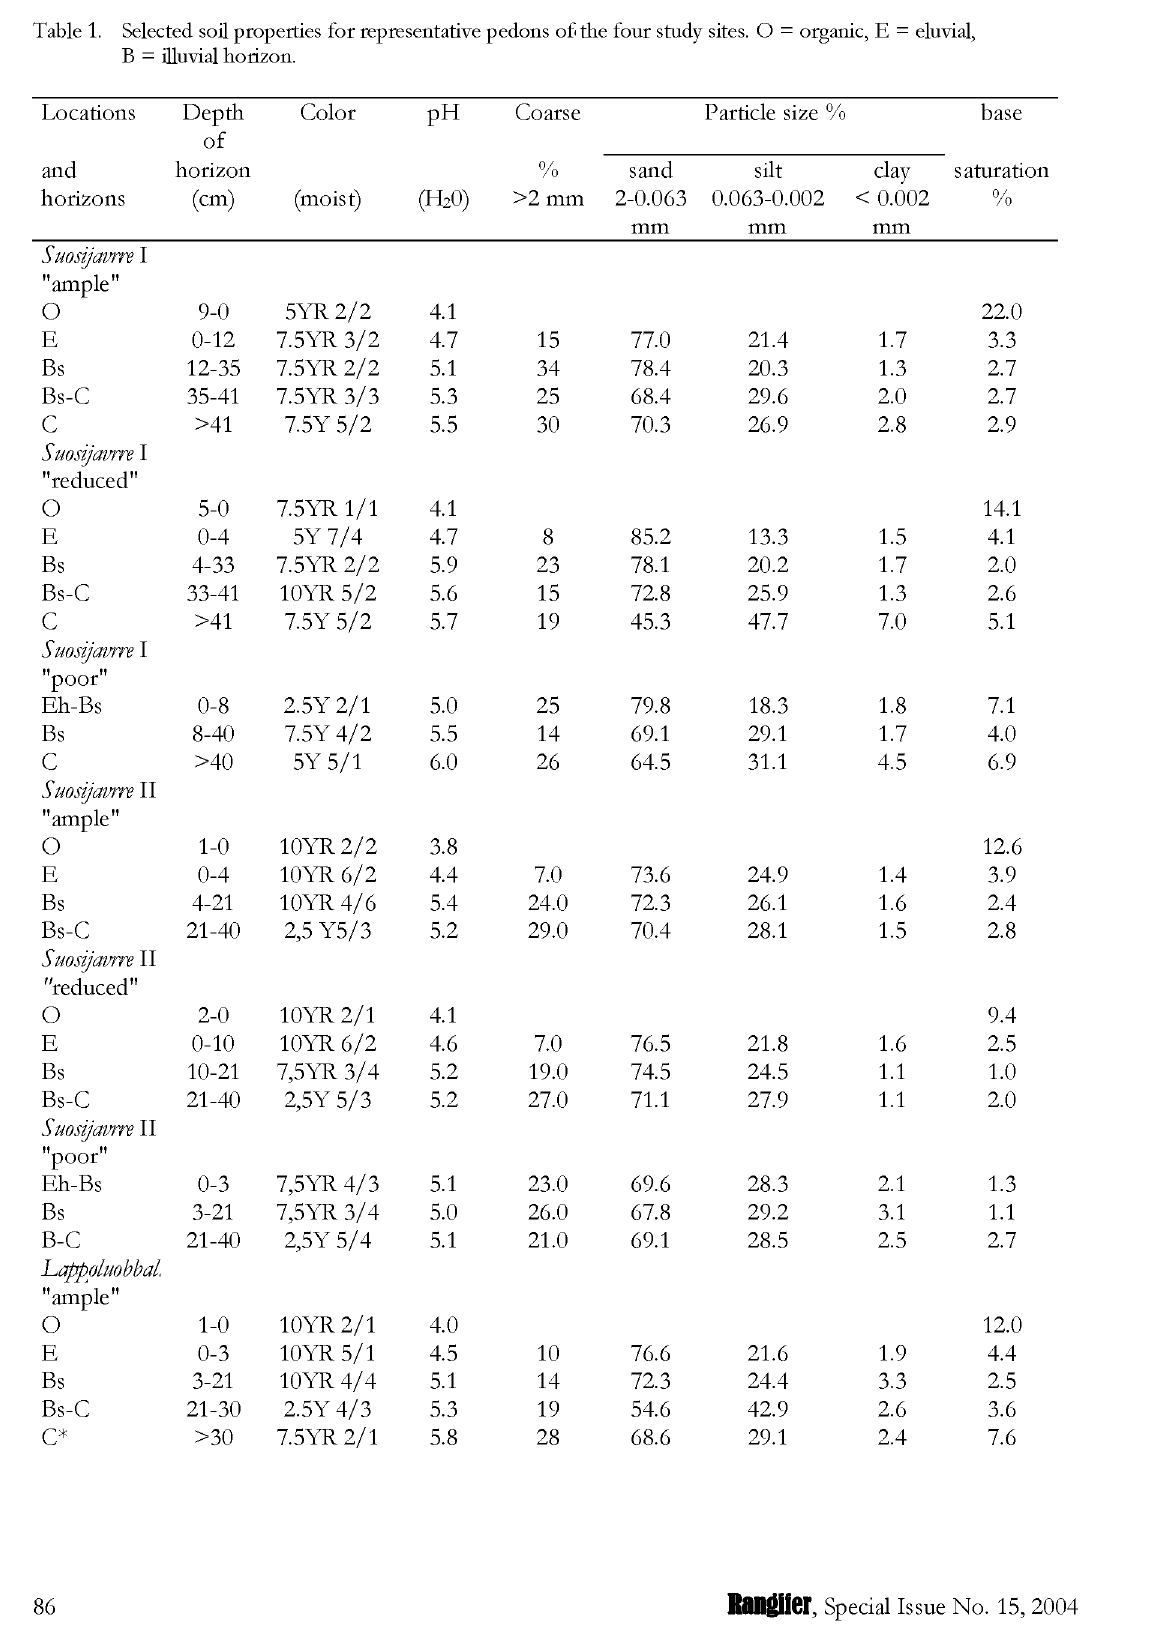
Table 1. Selected soil properties for representative pedons of the four study sites. O = organic, E = eluvial, B = illuvial horizon. Locations Depth Color pH Coarse Particle size % base of and horizon % sand silt clay